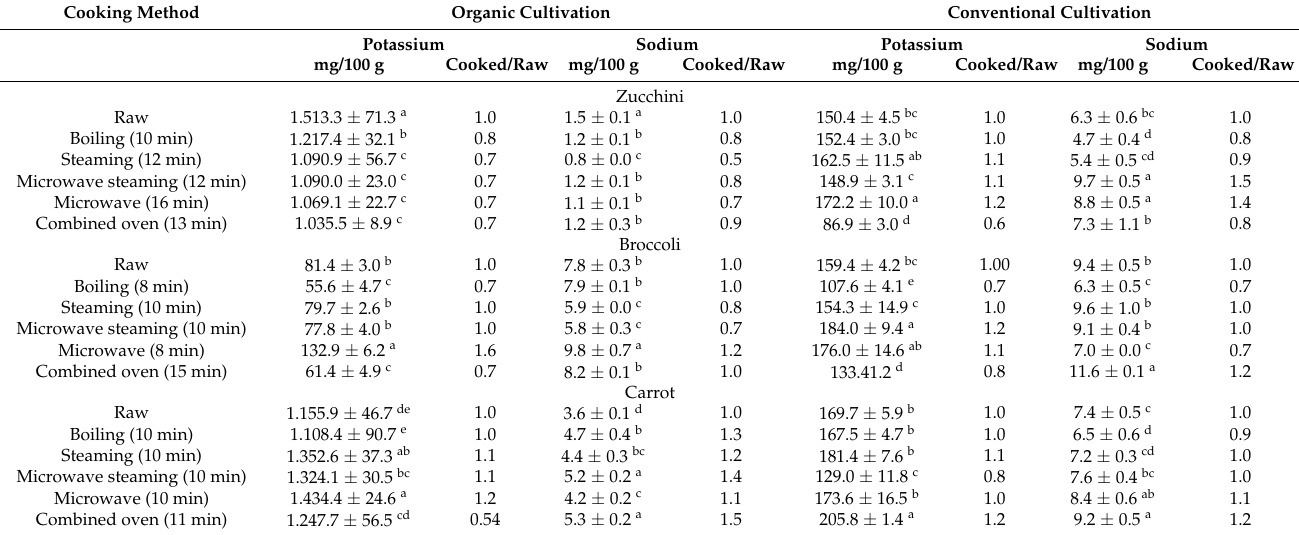
Table 2. Changes in potassium and sodium content in vegetables from organic and conventional cultivation, according to cooking method. Cooking Method